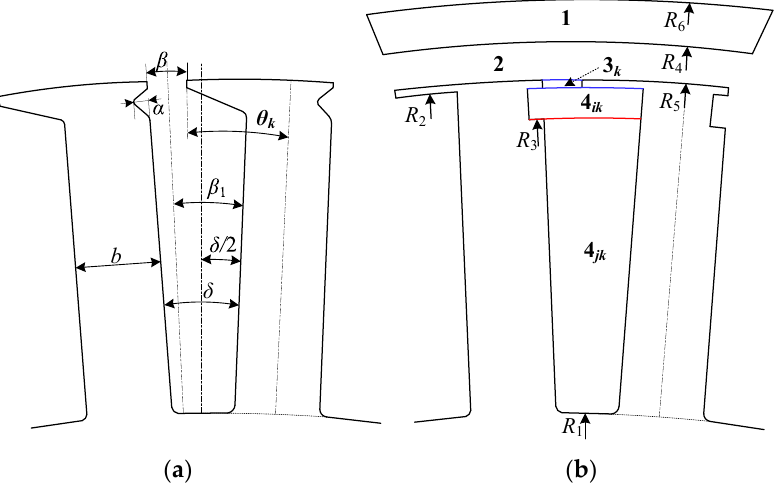
Figure 4. Single asymmetric stator slot model. ( a ) Original parametric model; ( b ) simplified model.